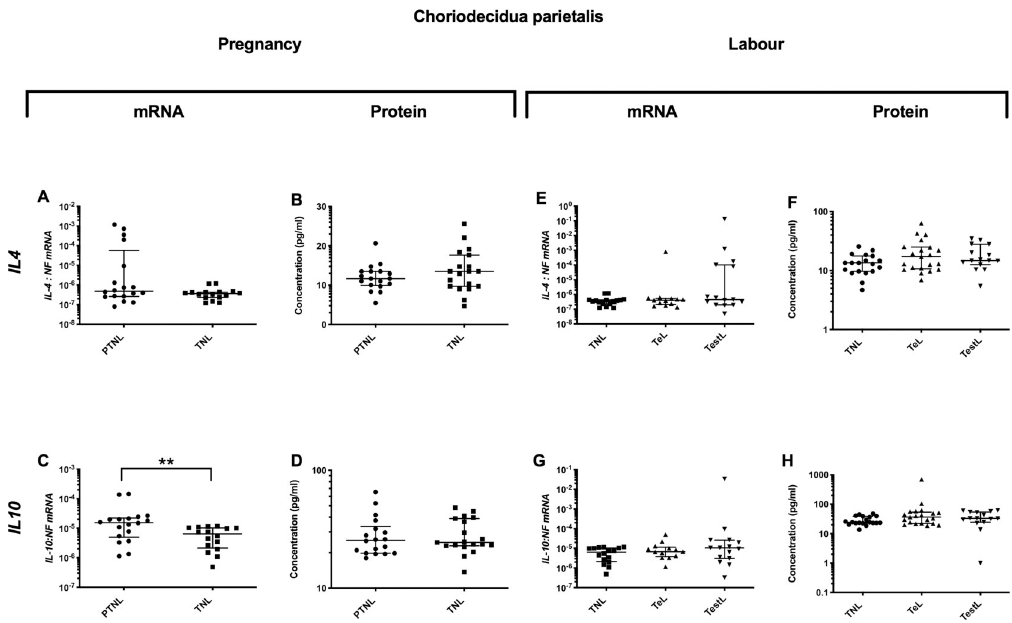
Fig 8. Anti-inflammatory changes in the choriodecidua parietalis. The cytokine levels in the choriodecidua parietalis samples obtained from four groups of women (mean gestational age ± SD in each case), PTNL (33.8 ± 1.7weeks, n = 17), TNL (39.3 ± 0.8 weeks, n = 19), TeL (38.4 ± 1.3weeks, n = 21) and TestL (39.5 ± 1.0, n = 15) were compared. Tissue levels of the cytokines were quantified using Bio-plex human cytokine 19-plex-array kit (Bio-rad) and a separate assay for CCL5 as describe in Materials and Methods . A subset of choriodecidua parietalis samples, PTNL (33.8 ± 1.7 weeks, n = 17), TNL (39.3 ± 0.9 weeks, n = 16), TeL (38.6 ± 1.2 weeks, n = 13) and TestL (39.5 ± 1.0, n = 15) were used to compare the mRNA expression using rtPCR of IL4 and IL10 . Normally distributed data were analysed using a Student’s t-test and data not normally distributed were analysed using a Mann Whitney test. The data are shown as median with interquartile range. The p values are demonstrated by � is p < 0.05 and �� is p <